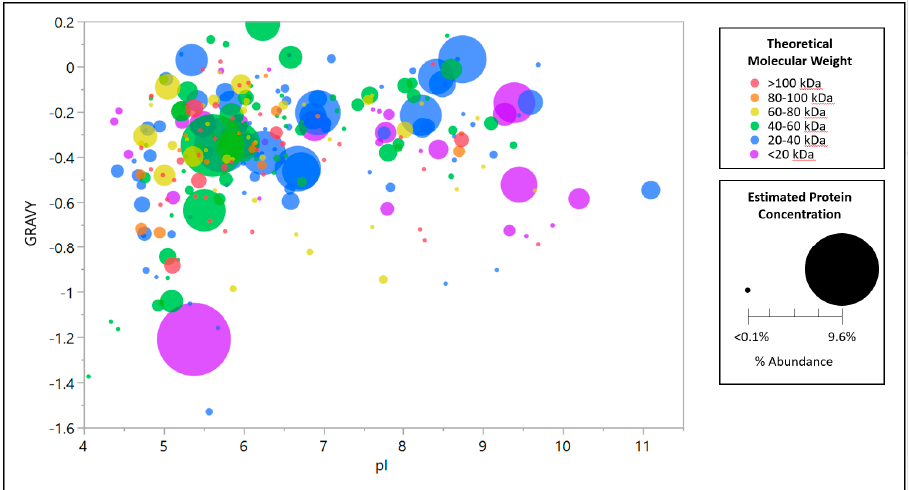
Figure A1. Host cell protein bubble plot distribution by approximate molar percent abundance, theoretical molecular weight, theoretical isoelectric point, and grand average of hydropathy clarified for null CHO-S cell culture harvest material used in this work as the HCP population fluorescently tagged for solid phase peptide library screening for null CHO-S abundance.